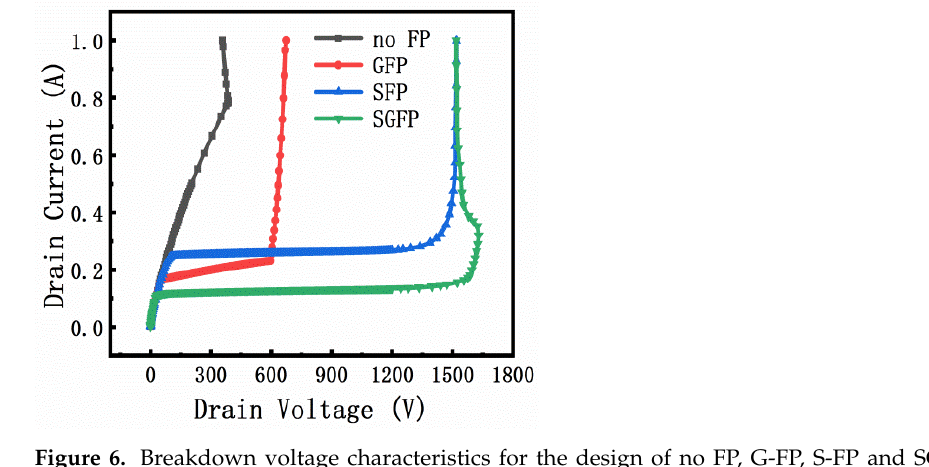
Figure 6. Breakdown voltage characteristics for the design of no FP, G-FP, S-FP and SG-FP, for L GFP = 4 μm and L SFP = 16 μm.